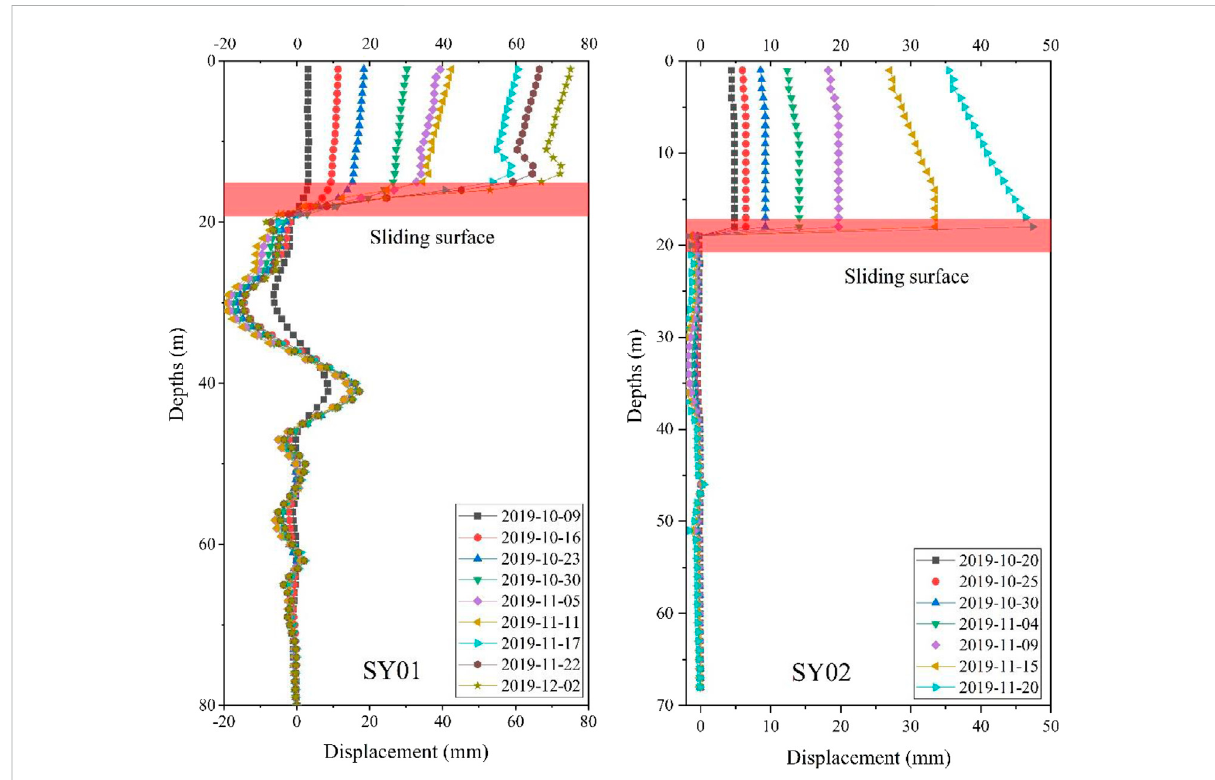
FIGURE 9 The cumulative displacement monitoring results of inclinometers SY01 and